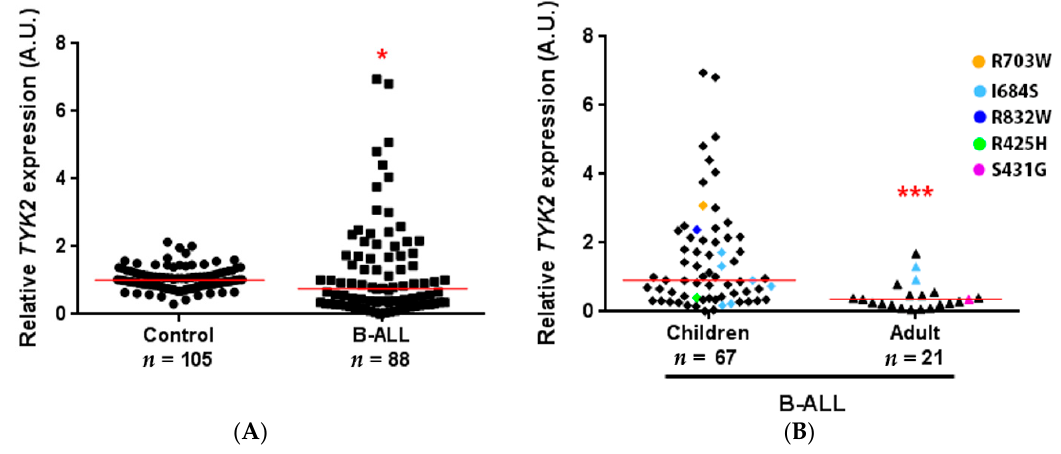
Figure 6. TYK2 expression in B-cell precursor acute lymphoblastic leukaemia (B-ALL) patients. qPCR was performed on cDNA obtained from 1 μ g of RNA isolated from the bone marrow of B-ALL patients and peripheral blood mononuclear cells (PBMCs) of healthy donors. For each sample, data were standardised against GAPDH expression. ( A ) Total B-ALL patients compared to healthy donors. Red line shows the median in each group (1.009 vs. 0.7594). ( B ) Age-related TYK2 expression in B-ALL patients. Children under 18 years compared to adults (median: 0.9147 vs. 0.3609). Patients with TYK2 variants are highlighted with different colours. * p < 0.05, *** p ≤ 0.001. n =